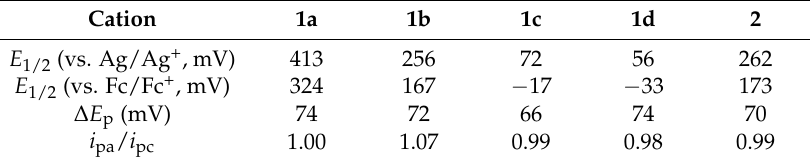
Table 1. Potential data of 1a – 1d and 2.